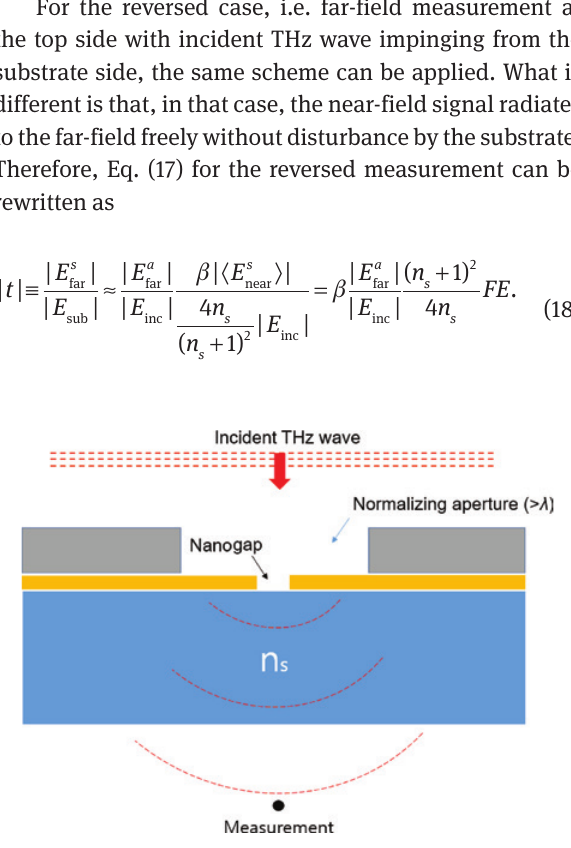
Figure 12: Schematics for the Kirchhoff method with